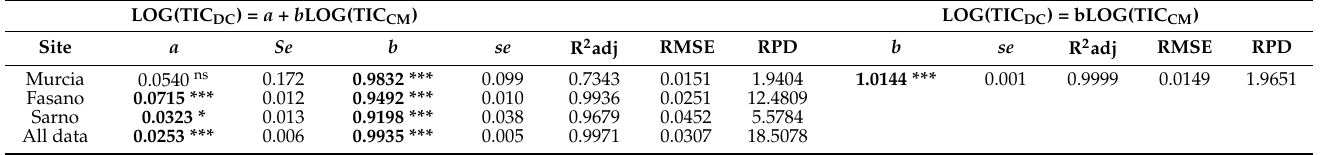
Figure 2. Linear regression between soil total inorganic carbon quantified through calcimeter (TIC CM ) and dry combustion (TIC DC ) methods on the whole data set (n = 117). The fitted equation is TIC DC = 0.99351 TIC CM + 0.02531 (R 2 = 0.9971). Table 5. Parameters of linear regression equations fitted to the data grouped per experimental site and to the whole data set.